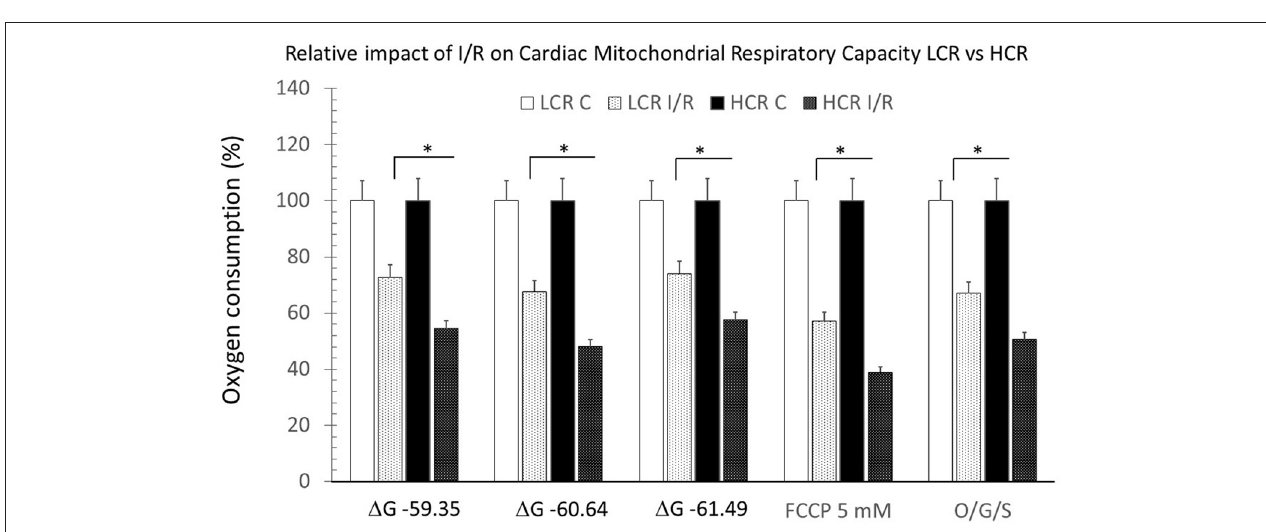
FIGURE 6 | Summary of mitochondrial respiration, comparing results within and between phenotypes, under control and post-ischemia-reperfusion (IR) conditions. Data are expressed as mean ± SD. n = 8 per group for controls and 9 per group for IR. * p < 0.05 in designated